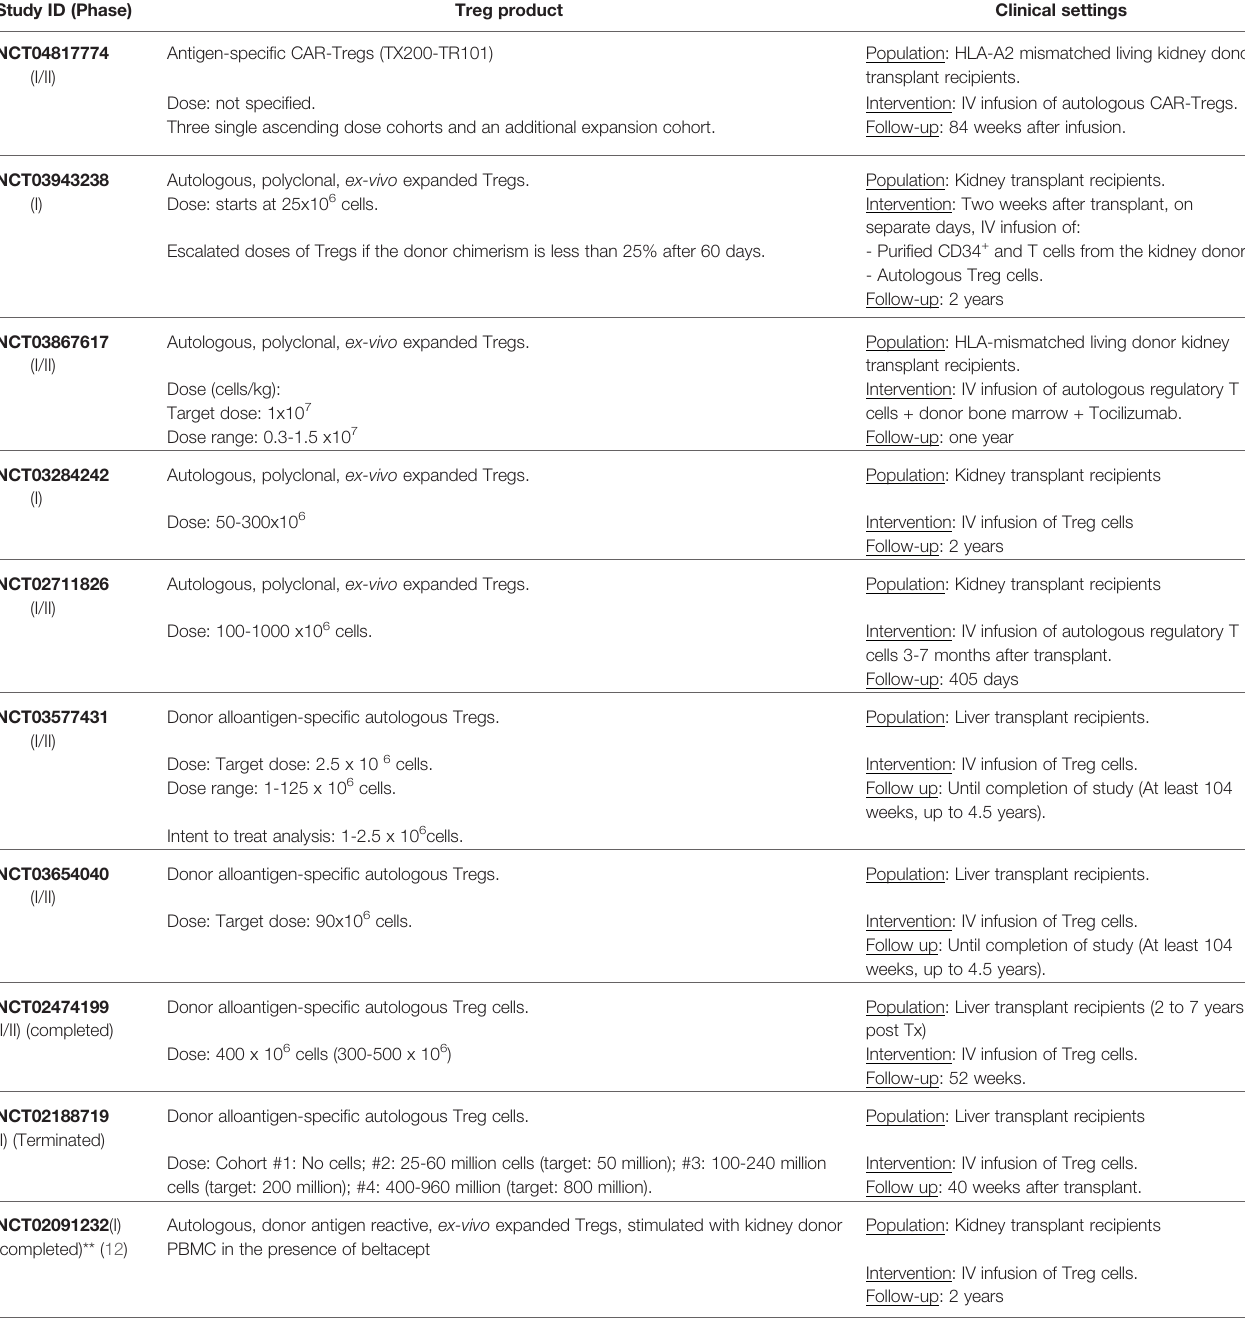
transplant recipients.